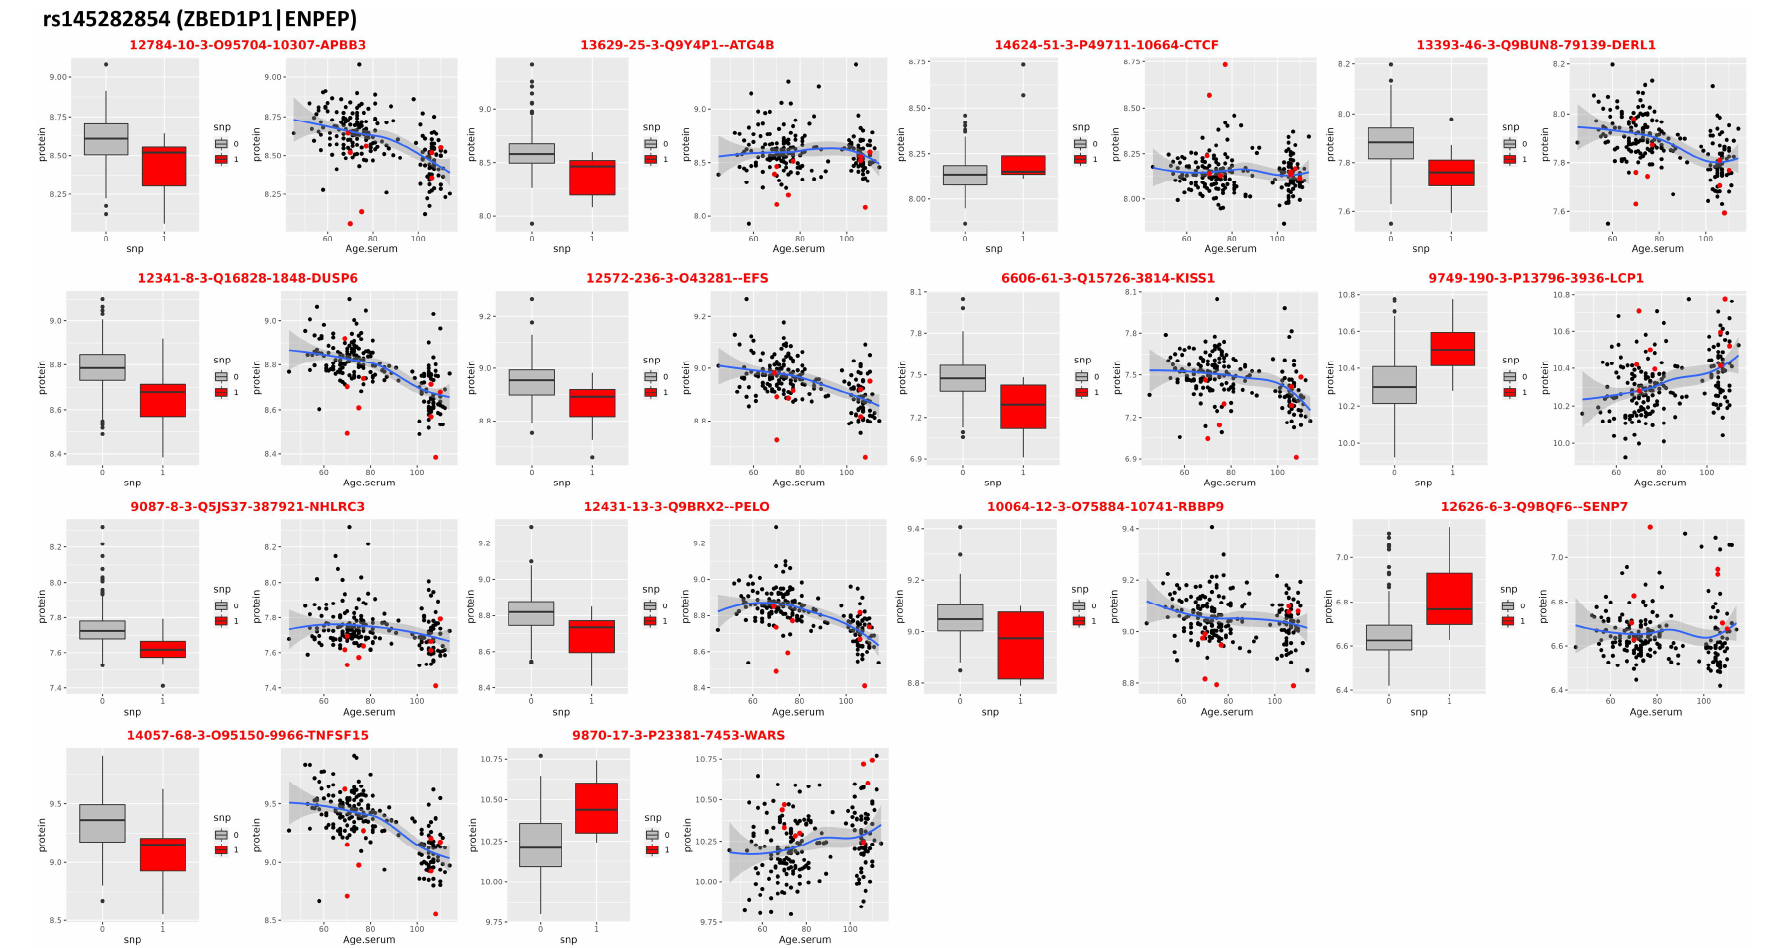
Figure 5. pQTLs in ZBED1P1 | ENPEP . Proteins that correlate with genotypes of the SNP rs145282854 that was associated with extreme human longevity in the discovery GWAS. For each protein: the boxplots on the left show the distribution of the log-transformed protein data by genotype group (red = heterozygote genotype of carriers of the longevity allele; gray/black = genotypes of carriers of two non-longevity alleles); the scatter plot on the right shows the distribution of the log-transformed protein data ( y -axis) versus the ages of study participants ( x